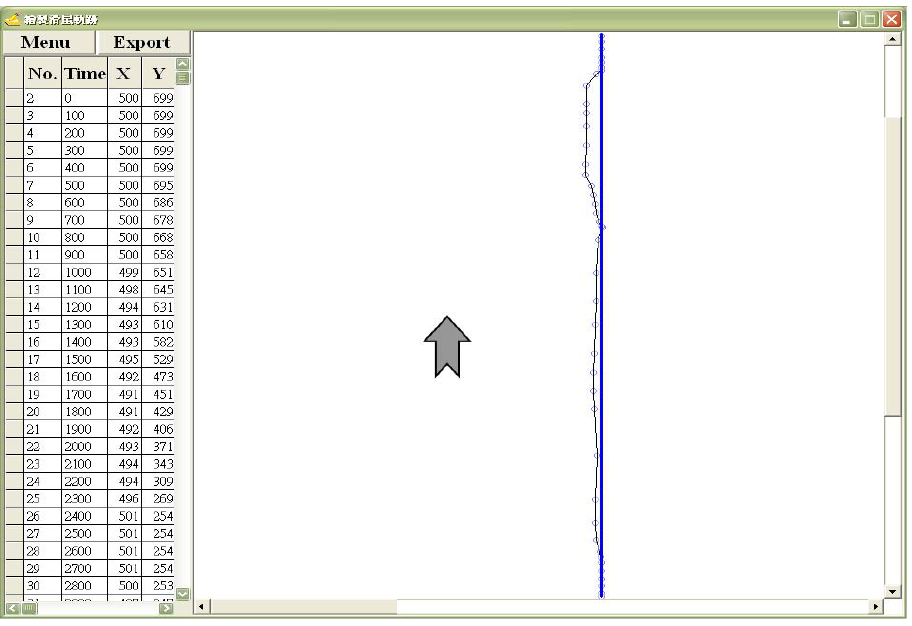
Figure 2. The graphical user interface (GUI) was used for displaying path and data coordinates during the cursor moving task of this study. In the right part of the screen, the blue line indicated the optimal trajectory of cursor moving and the black dotted line showed the subjects’ tracking path. The tracking path was sampled every 100 ms and the coordinates are displayed in the left table of the screen simultaneously during the upward moving